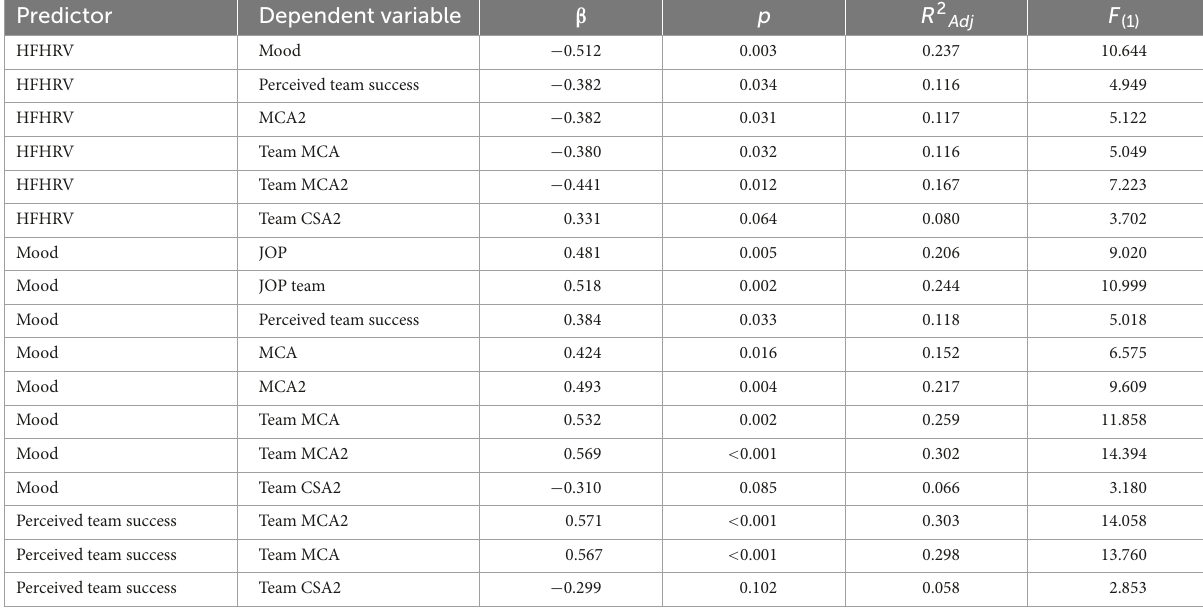
TABLE 2 Results for linear regression analyses ( N = 32). Predictor Dependent